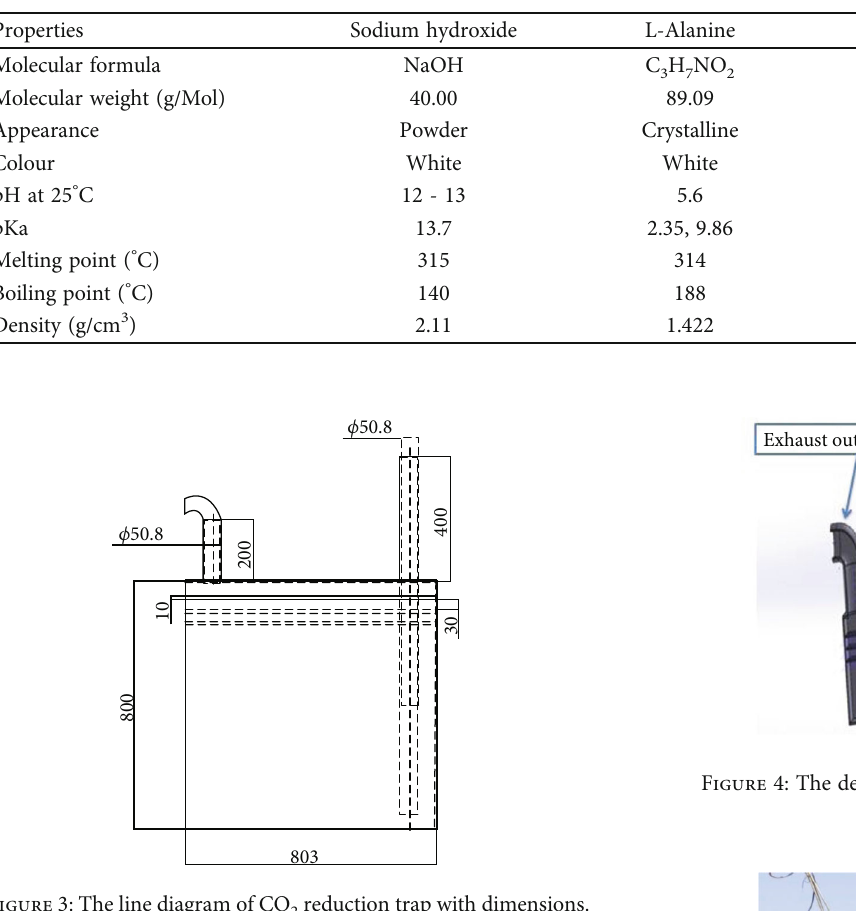
reduction trap with dimensions. 2